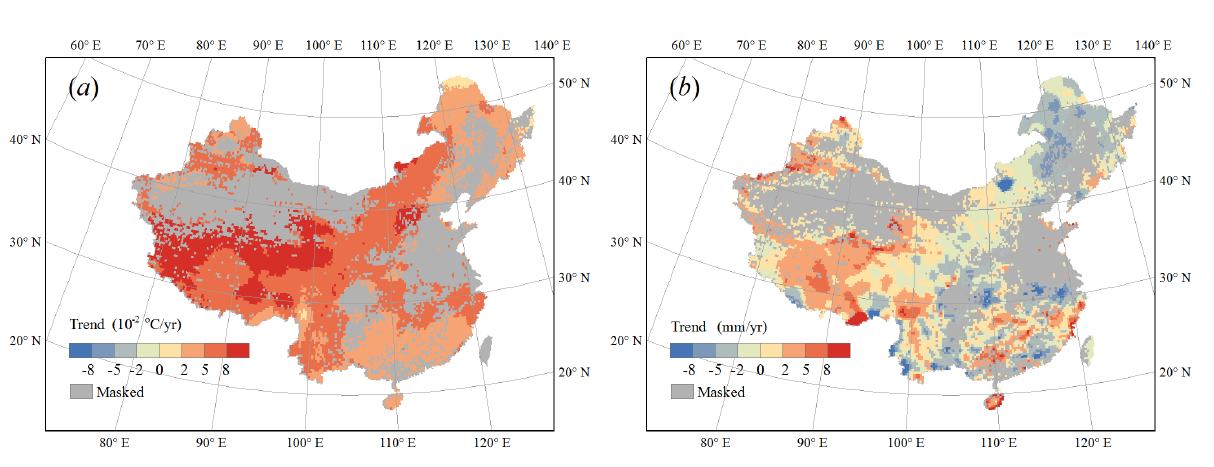
Figure 4. Map of growing season ( a ) temperature and ( b ) precipitation trends across China from 1982 to